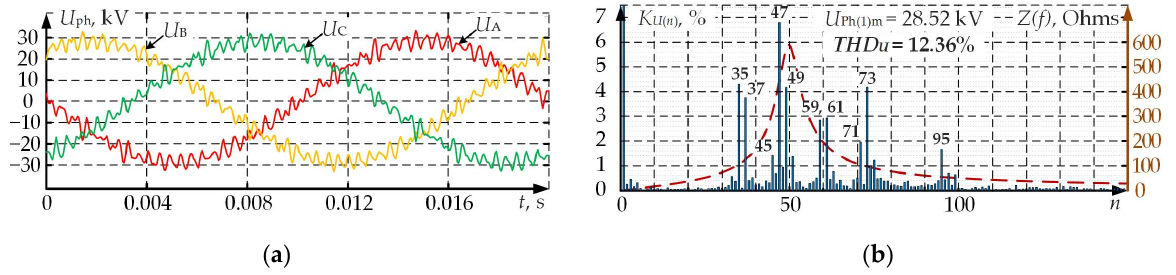
Figure 13. The immediate values of the line voltage in the 34.5 kV buses ( a ) and their harmonic spectrum ( b ).